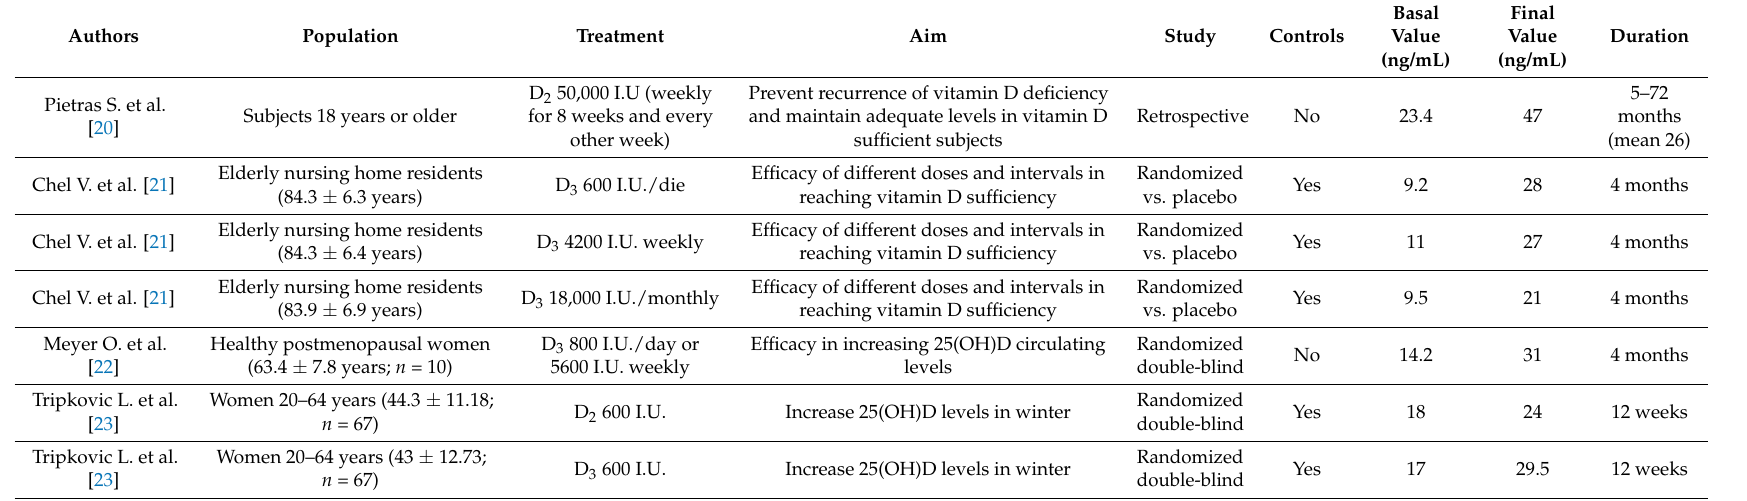
Table 2. Main features of studies addressing vitamin D repletion in normal